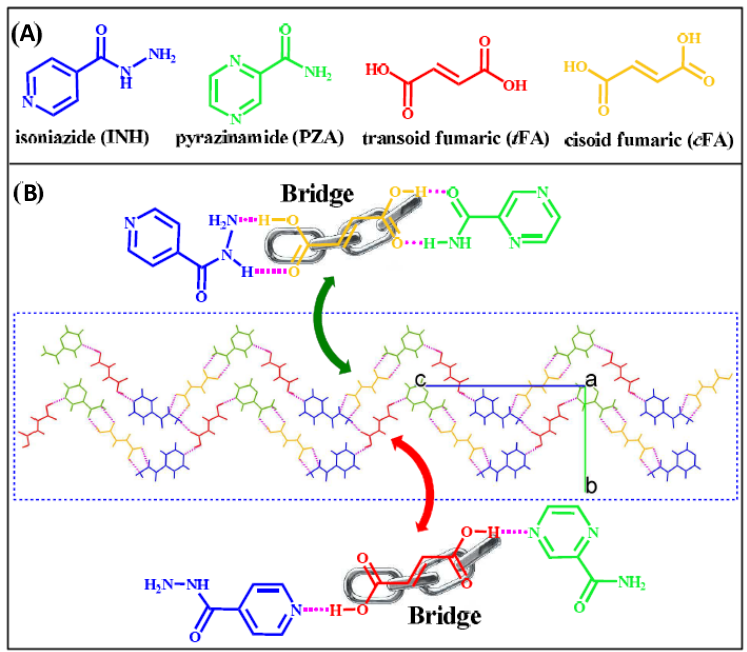
Figure 23. ( A ) Chemical structures of isoniazid, pyrazinamide, trans and cis fumaric acid, ( B ) Schematic representation of fumaric acid acting as a bridge in interconnecting isoniazid and pyrazinamide molecules [Reprinted from [261] with permission. Copyright 2018 American Chemical Society].